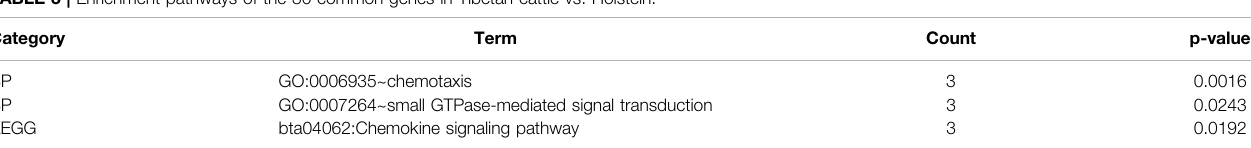
TABLE 3 | Enrichment pathways of the 30 common genes in Tibetan cattle vs.